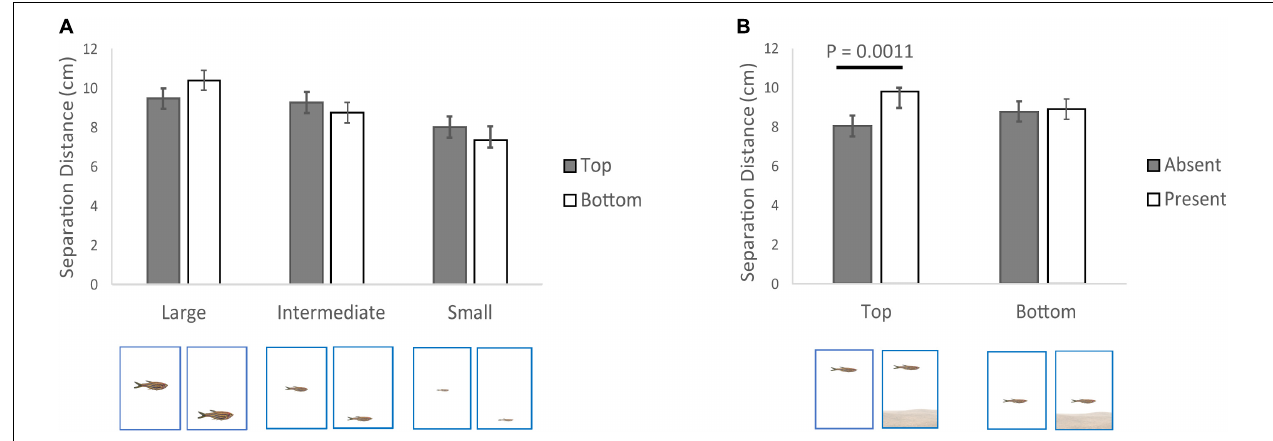
FIGURE 2 | Variation in separation distance between the zebrafish and virtual conspecific (cm) relative to the simultaneous effect of: (A) size of the conspecific (large, intermediate, small), (B) position of the conspecific in the water column (top, bottom) and (C) absence/presence of the visual horizon. Shown are means and SEs.